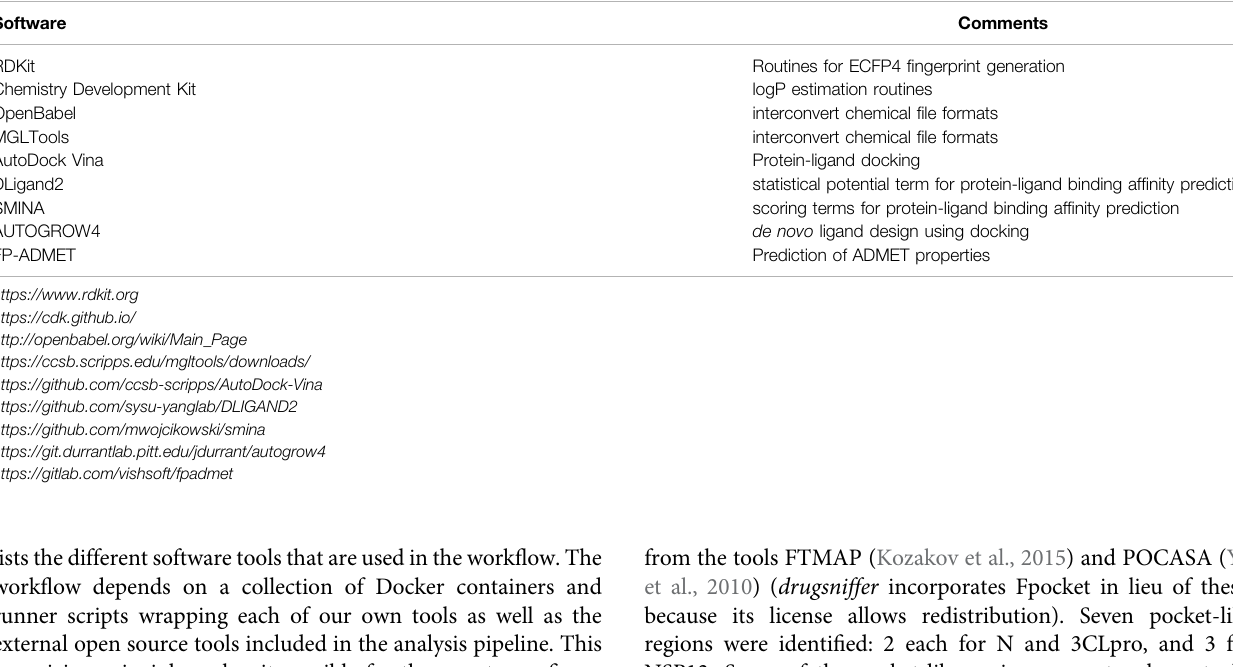
TABLE 3 | Software used in the VS